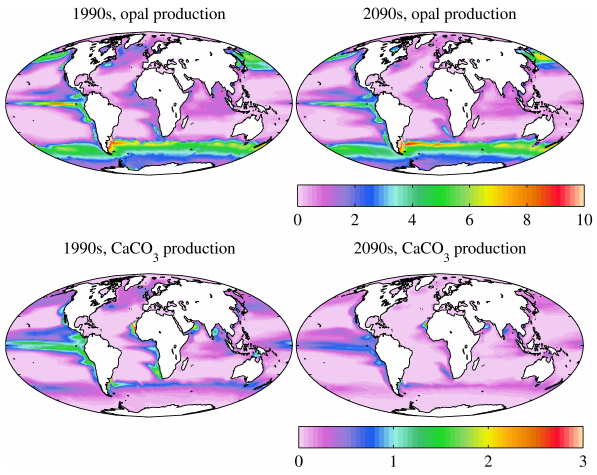
Fig. 16. Annual average 1990s (left) and 2090s (right) opal pro- Fig.14. Annualaverage1990s( left )and2090s( right )opalproduction( top ;mmolSim − 2 d − 1 )andCaCO 3 production ( bottom ;mmolCm − 2 d − 1 ). duction (top; mmolSim − 2 d − 1 ) and CaCO 3 production (bottom; mmolCm − 2 d − 1 ).